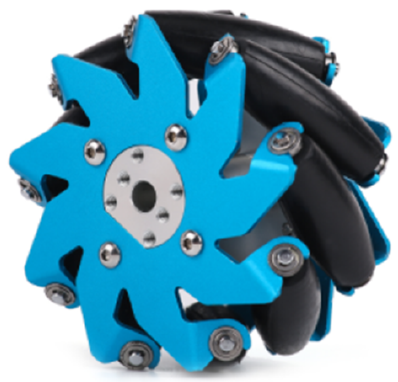
Figure 2. Mecanum wheel.